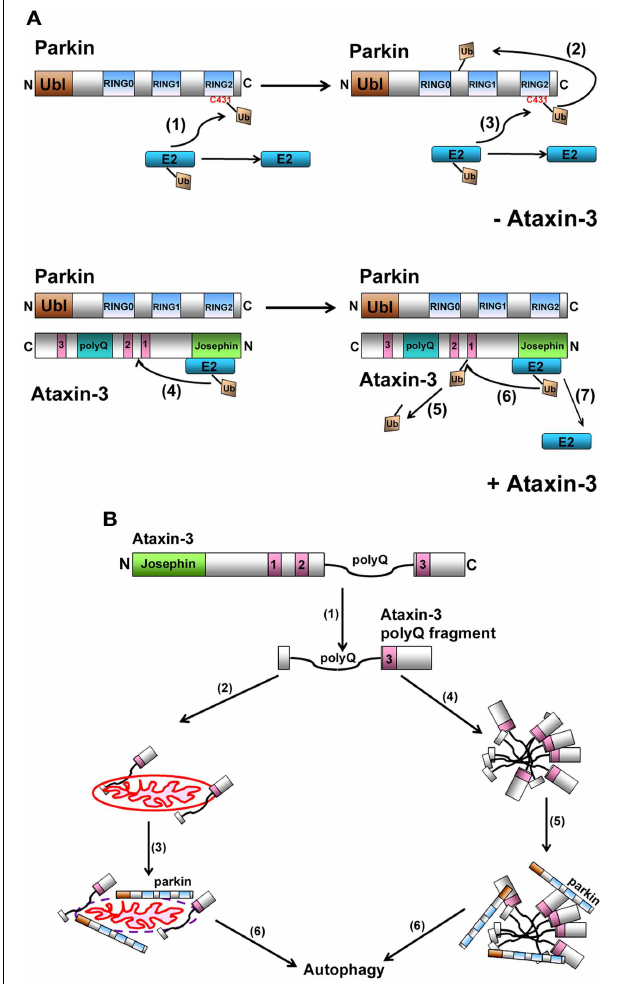
FIGURE 2 | (A) Model representation of how ataxin-3-mediated deubiquitination regulates parkin self-ubiquitination.When parkin ubiquitinates itself, the charged E2-Ub thioester transfers the Ub onto C431 in parkin to form a transient parkin-Ub thioester complex (1). Parkin now transfers this Ub onto one of its own lysines generating an isopeptide linkage (2). Following the transfer of Ub onto itself, parkin is now free to receive a new Ub and this continues the cycle of parkin self-ubiquitination (3).When ataxin-3 is present, we propose that ataxin-3, through its interaction with the IBR-RING2 domain of parkin, blocks the C431 residue, impeding parkin from forming a parkin-Ub thioester. Instead, ataxin-3 now interacts with the E2, directing the transfer of Ub onto a lysine within ataxin-3 (4).This isopeptide linkage is transient as ataxin-3 can catalyze its removal (5) (unpublished data), allowing ataxin-3 to repeat this cycle of self-ubiquitination/deubiquitination, thereby reducing the ability of parkin to ubiquitinate itself (6 and 7). (B) Proposed model for how the expanded ataxin-3 can promote the autophagic clearance of parkin. In the presence of calcium, calpains cleave full-length ataxin-3, generating fragments containing the expanded polyQ tract (1).These fragments can associate with mitochondria (2), causing mitochondrial damage, parkin recruitment (3), and ultimately parkin-mediated clearance of itself and the mitochondria via the autophagy pathway (6). Alternatively, these expanded polyQ fragments also have a propensity to aggregate (4), recruiting parkin and CHIP (5), which now act to direct these aggregates and themselves for autophagic clearance